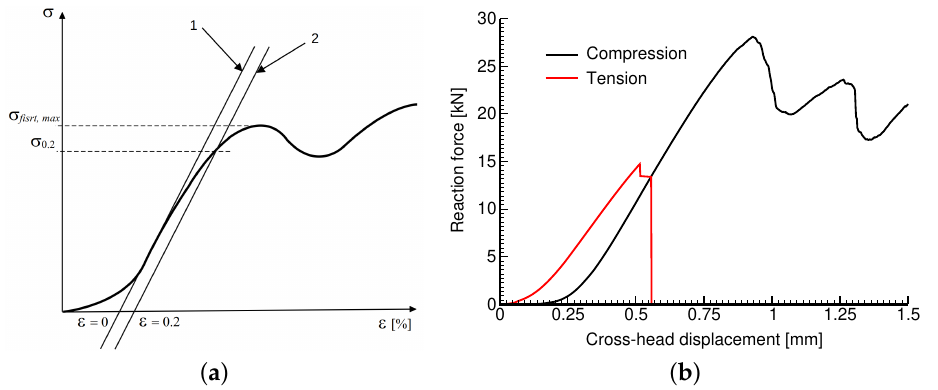
Figure 8. Engineering stress vs. engineering strain curve: ( a ) definition of basic mechanical parame- ters, ( b ) illustration of compressive and tensile stress–strain diagrams obtained